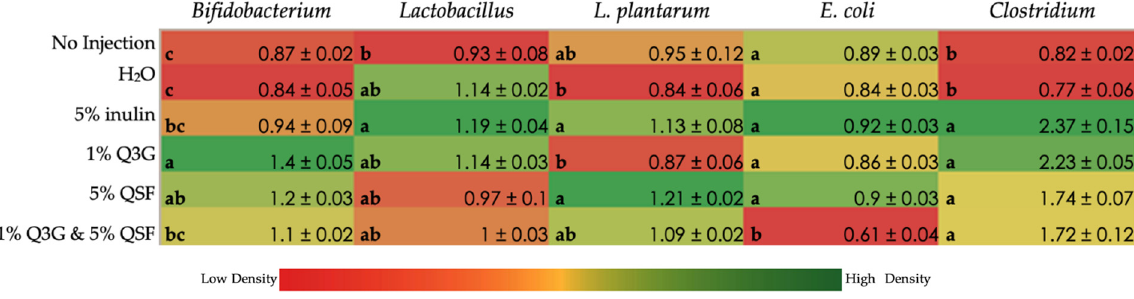
Figure 3. Effect of intra-amniotic administration of QSF and Q3G on genera and species level bacterial populations in the duodenum. Values are the means ± SEM, n = 6. Values (column wise) not indicated by the same letter are statistically significant ( p < 0.05). Q3G, quercetin 3-glucoside; QSF, quinoa soluble fiber.